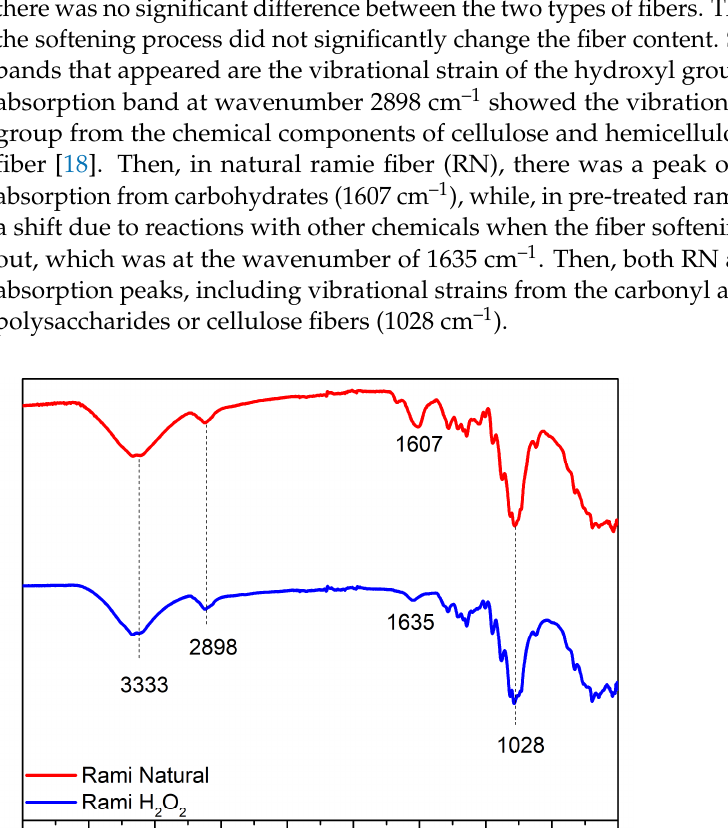
Figure 8. FTIR spectra of impregnated natural ramie. Figure 9 shows the FTIR spectrum of ramie pre-treated (RH) before finally being impregnated with tannin-based Bio-PU and tannin-based Bio-NIPU resins. There were absorption peaks that appeared as in RN tannin-based Bio-PU and RN tannin-based Bio-